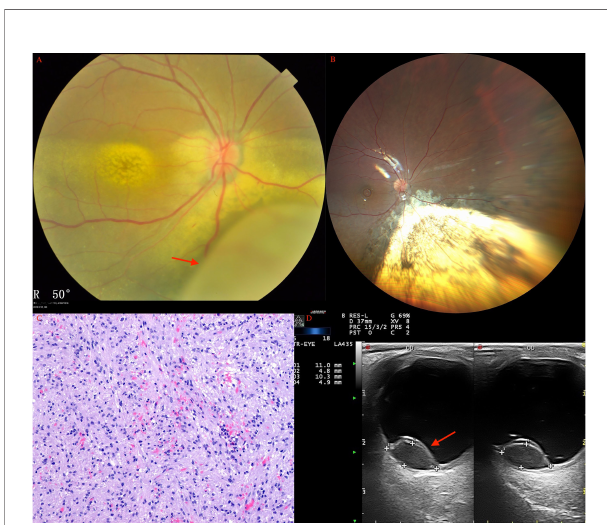
FIGURE 4 | Choroidal leiomyoma (arrow) of a 27-year-old woman before (A) and after (B) PTSU combined with MVRE. (C) Photomicrograph of leiomyoma showing bundles of spindle cells with blunt-ended oval nuclei (HE, ×100). (D) CDI revealed a pedunculated mass (arrow) with inconsistent re fl ectivity of moderate intensity, and arterial blood signals in the